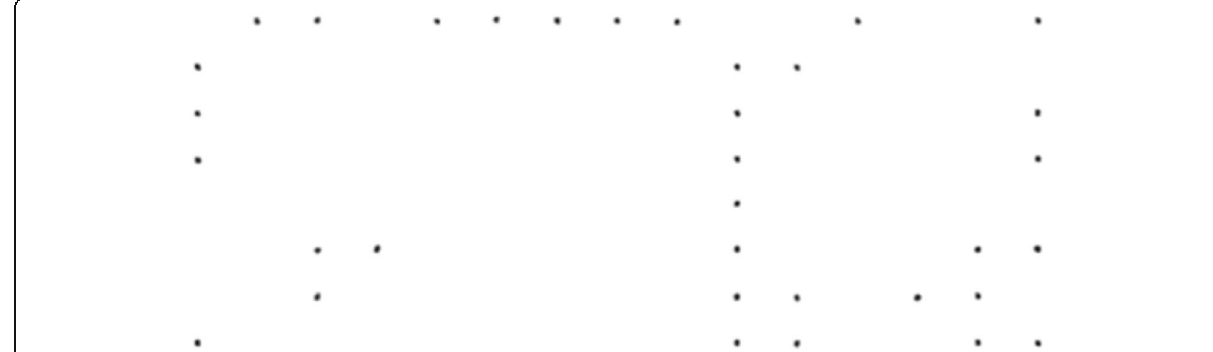
Fig. 9 The grayscale mode of the coded dots matrix embedded in a color laser printout of Xerox® sample